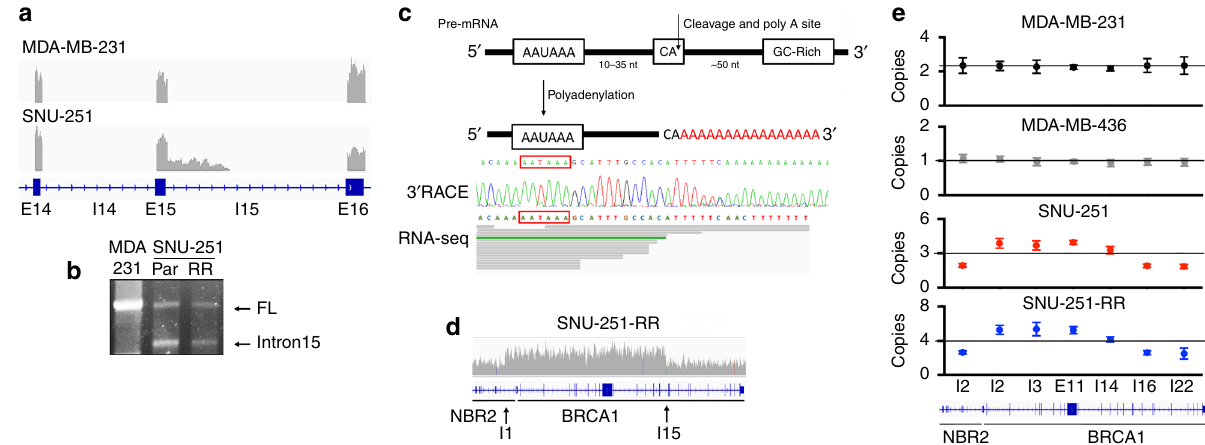
Fig. 2 Intronic polyadenylation occurs in SNU-251 cells. a Integrative Genomics Viewer (IGV) showing BRCA1 exons 14 – 16 reads detected using RNA-seq in MDA-MB-231 and SNU-251-RR cells. b Identi fi cation of BRCA1 transcripts by 3 ′ RACE. Representative gel image indicating BRCA1 full-length (FL) and intron 15 transcripts. c Cartoon showing a consensus AAUAAA polyadenylation signal that is followed by a CA cleavage and polyadenylation site 10 – 35 nucleotides downstream. Below, Sanger sequencing of BRCA1 intron 15 mRNA identi fi ed by 3 ′ RACE, polyadenylation sequence is highlighted. The corresponding 3 ′ reads detected by RNA-seq are shown for comparison. d IGV of SNU-251-RR WGS reads detected mapping to chromosome 17 NBR2 and BRCA1 gene locations. e Cells were assessed for genomic copy number using q-PCR at NBR2 intron 2, BRCA1 intron 2, intron 3, exon 11, intron 14, intron 16 and intron 22. Copy number is normalized to the signal detected in RPE nontransformed cells ( n = 2 copy number). Line shows the mean copy number for all reactions in each cell line. Data are the mean ± SD of n = 3 biological